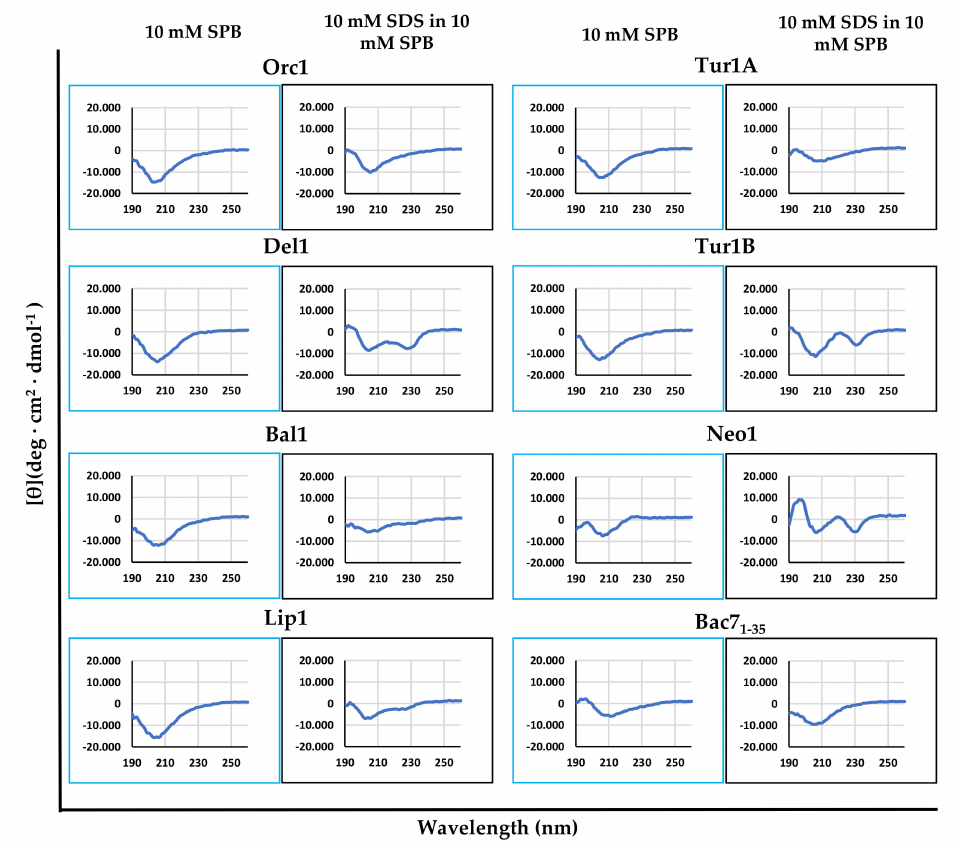
Figure 1. CD spectra of the peptides (20 µ M) in 10 mM sodium phosphate bu ff er (SPB, first and third columns) and in 10 mM sodium dodecyl sulphate (SDS) in 10 mM SPB (second and